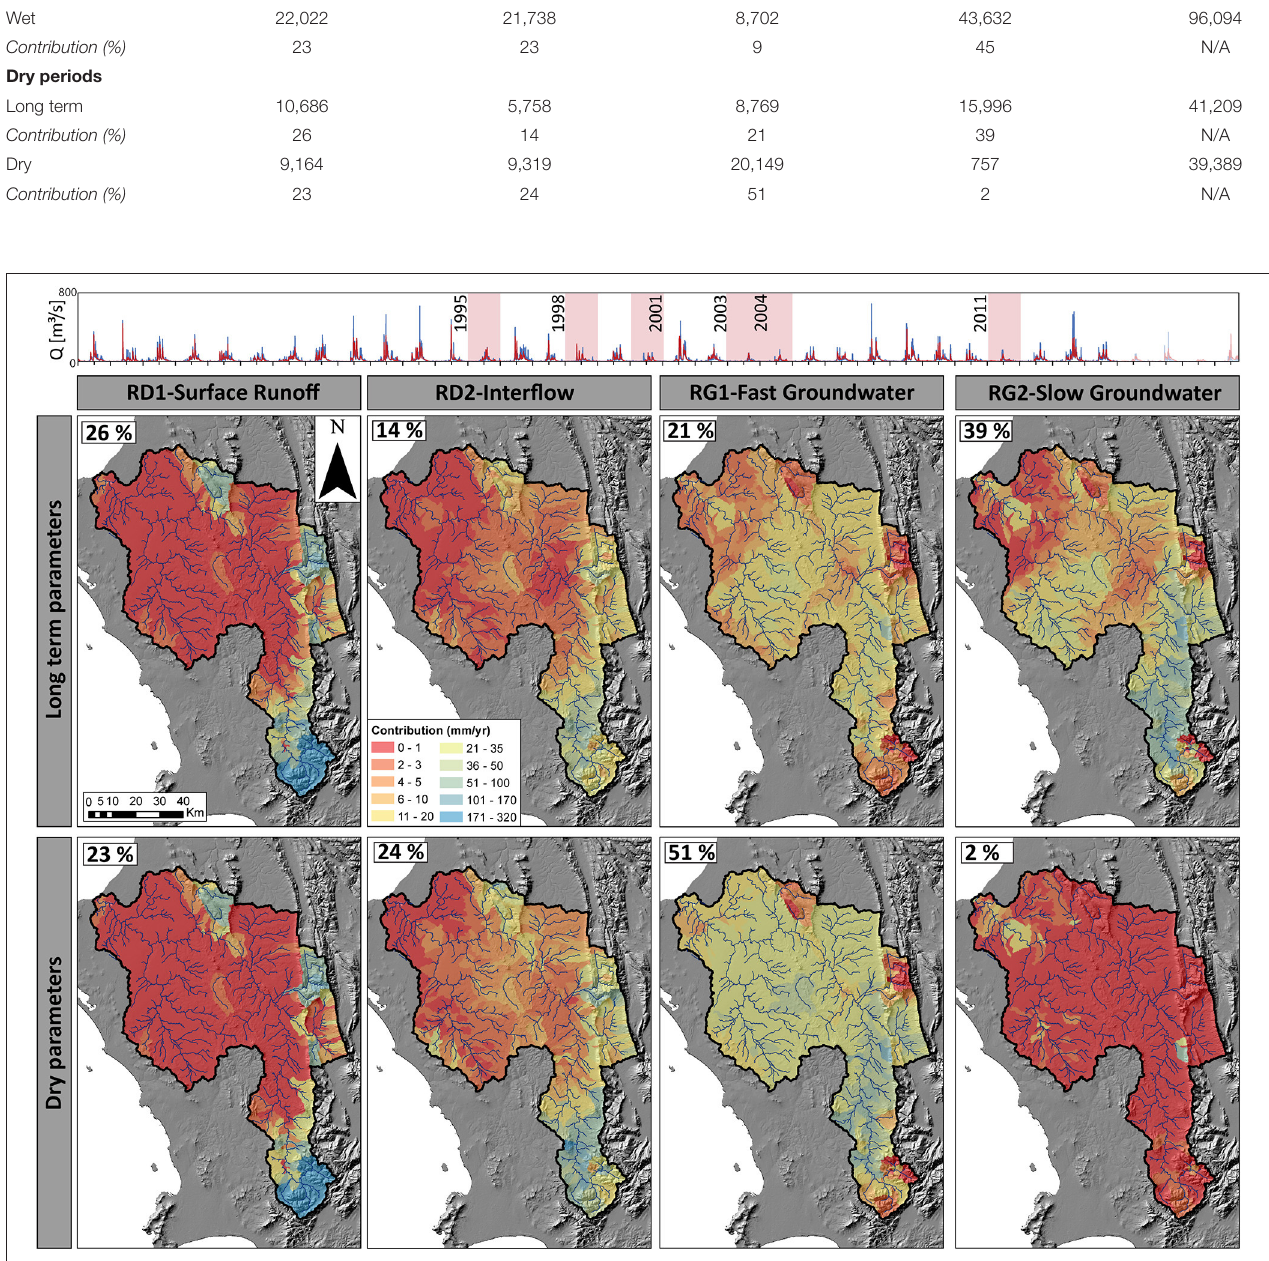
FIGURE 6 | The long-term (1984–2018) time series of the simulated (red line) and observed streamflow (blue line) with the yearly contribution of surface runoff (RD1), interflow (RD2), fast groundwater (RG1) and slow groundwater (RG2) for the identified dry periods (1995, 1998, 2000, 2003–2004, and 2011) using the parameters θ long − term and θ dry with the average percentage contribution for each of the flow components. Spatially θ long − term and θ dry were similar, with a dominance of flow in the catchment headwater areas (south), but differed by the total contribution for interflow (10%), slow (30%) and fast groundwater (37%).